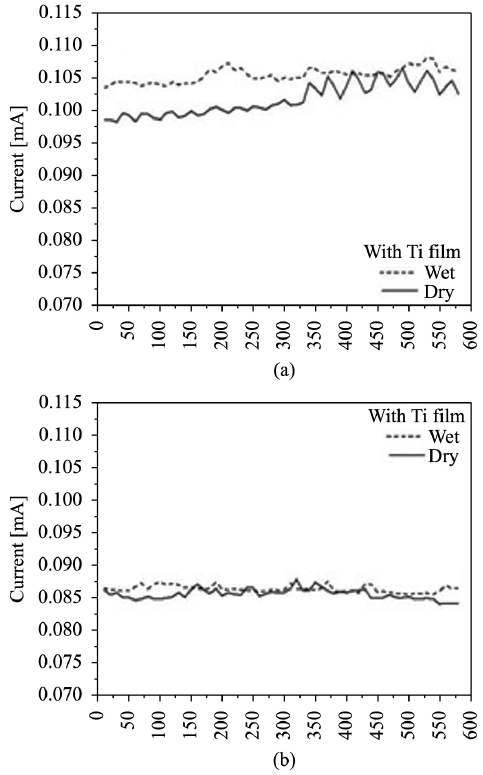
Figure 5. (a) Maximum leakage current obtained on an insulator without deposition before and after accelerated aging; and (b) on an insulator with nanometric film deposition before and after accelerated